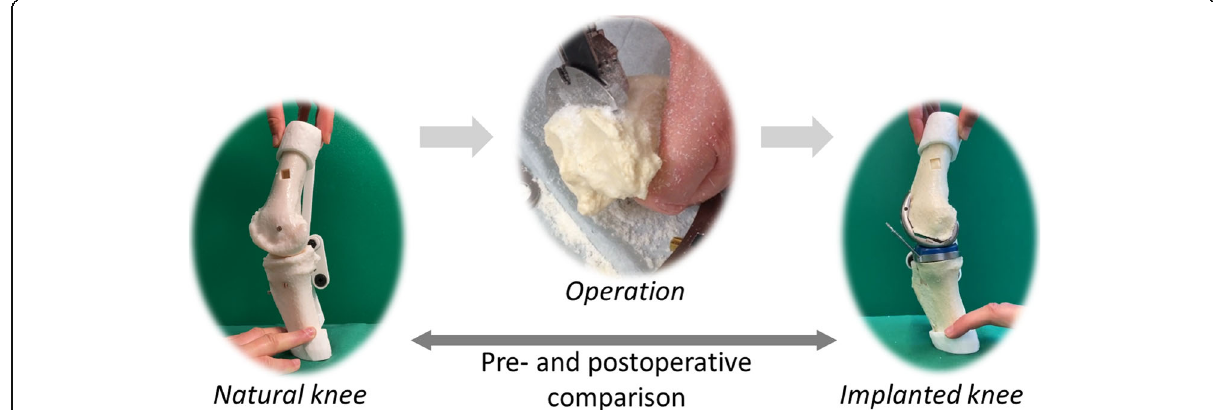
Fig. 1 Illustration of the proposed 3D model to compare pre- and postoperative kinematics and behavior of the knee